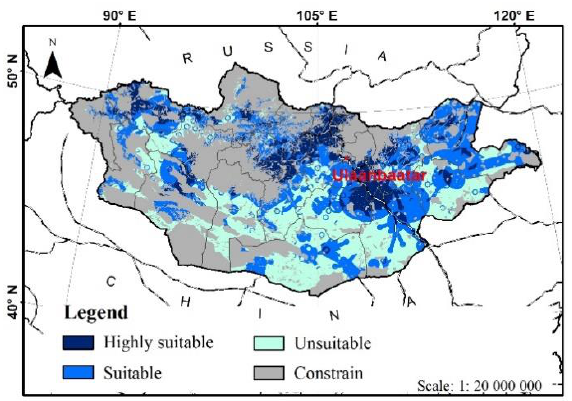
Figure 4. Suitability classification map for metallurgical and